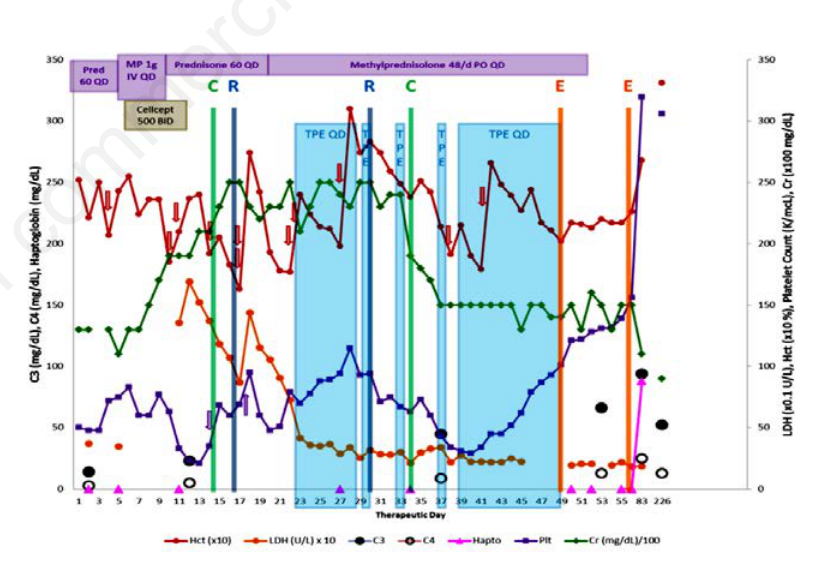
Figure 2. Therapeutic course. Horizontal lavender boxes depict steroids [and hydroxy- chloroquine (HQ) course; PO = Prednisone dose; MP = Methylprednisolone, 1 gram]. M = Mycophenolate Mofetil; R = Rituximab (1000 mg IV); C = Cyclophosphamide (C1 500 mg IV; C2 800 mg IV); E = Eculizumab; PE = Therapeutic Plasma Exchange; QD = daily; IV = Intravenous. Note that platelet counts were responsive to TPE but hemolysis-engen- dering-transfusion (downward pointing arrows, each one representing a unit of RBCs) continued in the face of continued plasma exchange. Eculizumab was dosed on days 49 (900 mg IV shown), 56 (900 mg IV shown), and 63 (900 mg IV, not shown), 70 (900